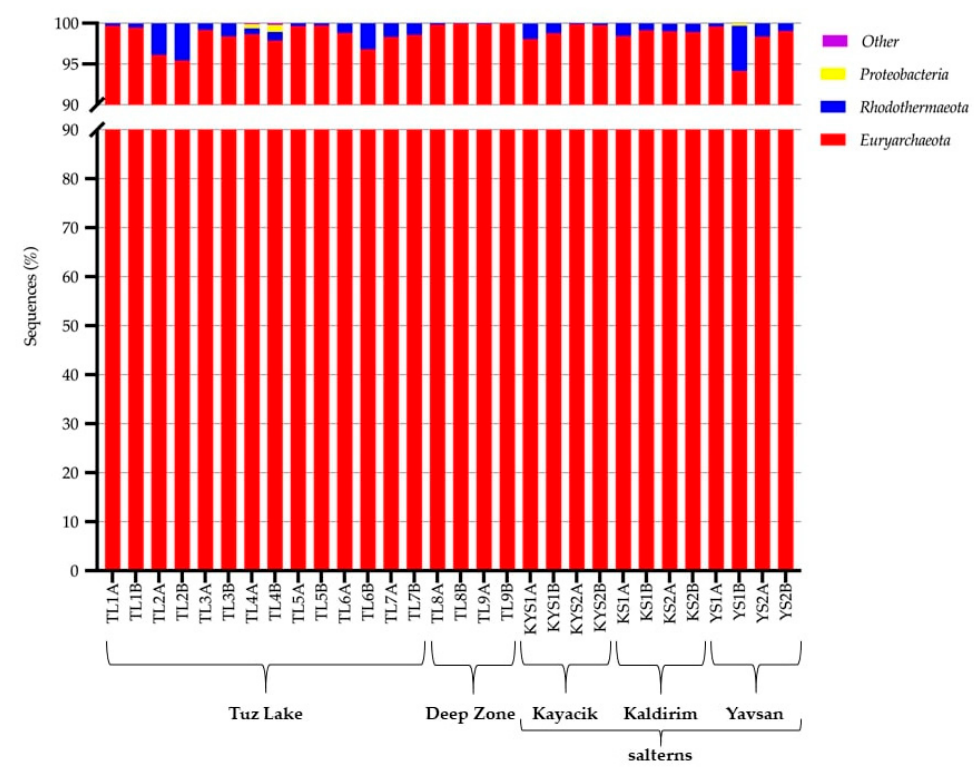
Figure 2. Phyla distributions of prokaryotic communities determined in brine samples of Tuz Lake (TL1A to TL7B), Deep Zone (TL8A to TL9B), and Kayacik (KYS1A to KYS2B), Kaldirim (KS1A to KS2B), and Yavsan (YS1A to YS2B) salterns.